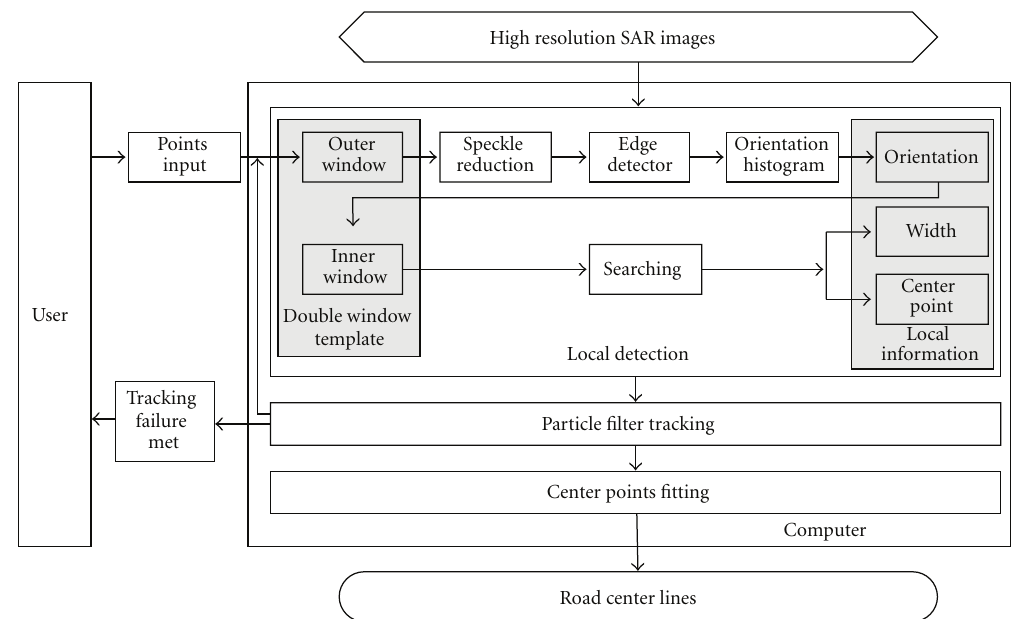
Figure 2: Semiautomatic road centerline extraction framework.